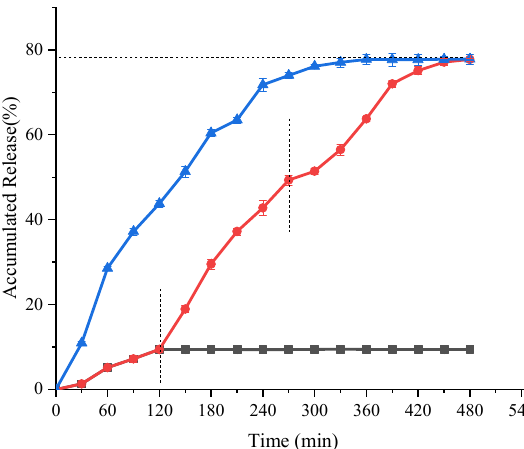
Figure 7. Releasing properties of saponin in vitro. Black curve shows the variation of saponin release from the composite hydrogel loaded with saponin in simulated gastric fluid (pH 2.0) as a function of time; red curve shows the cumulative release curve for the composite hydrogel samples loaded with saponin; blue curve shows the release of saponin in simulated intestinal fluid (pH 7.5) for the composite hydrogel samples loaded with saponin with time.